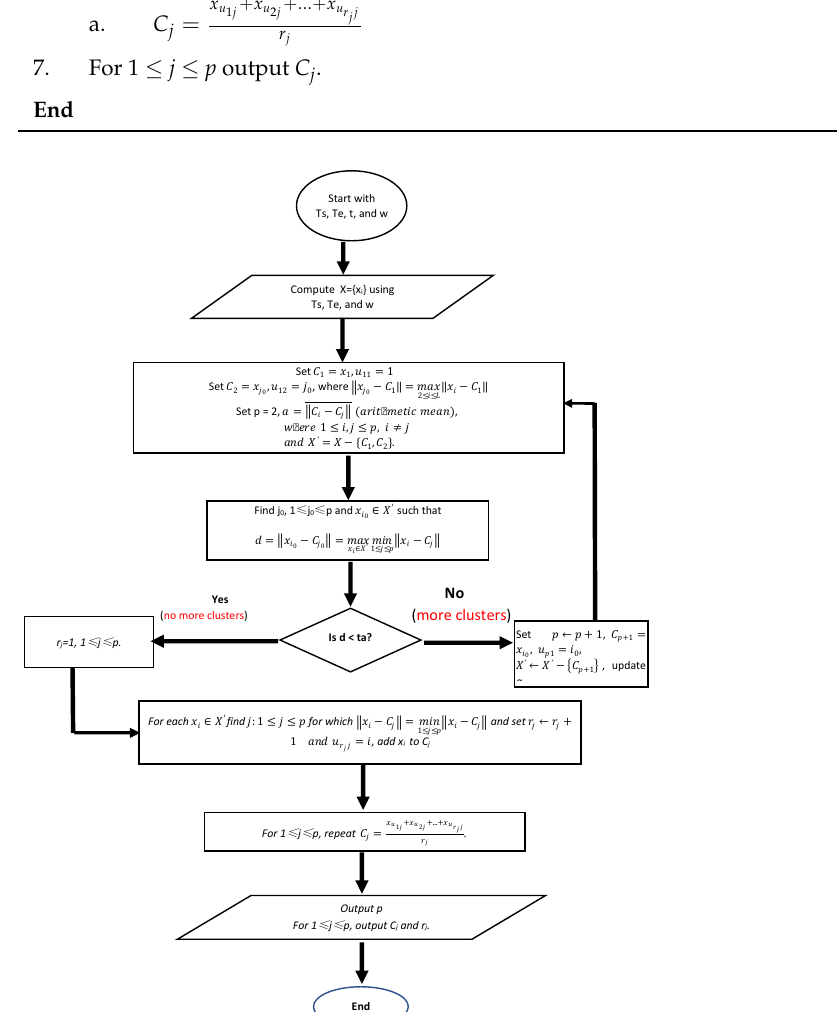
Figure 3. The flow chart for the Packet matching Algorithm.